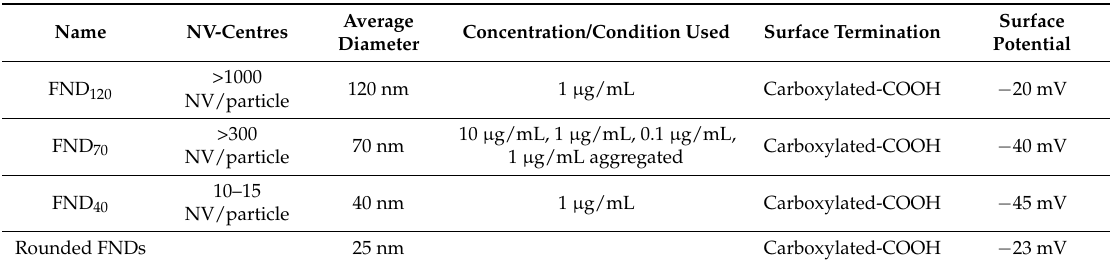
Table 1. Diamond